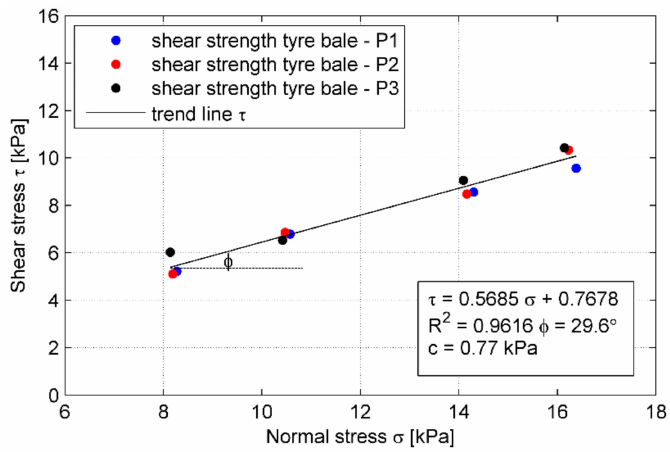
Figure 22. Shear strength envelope for tyre–soil